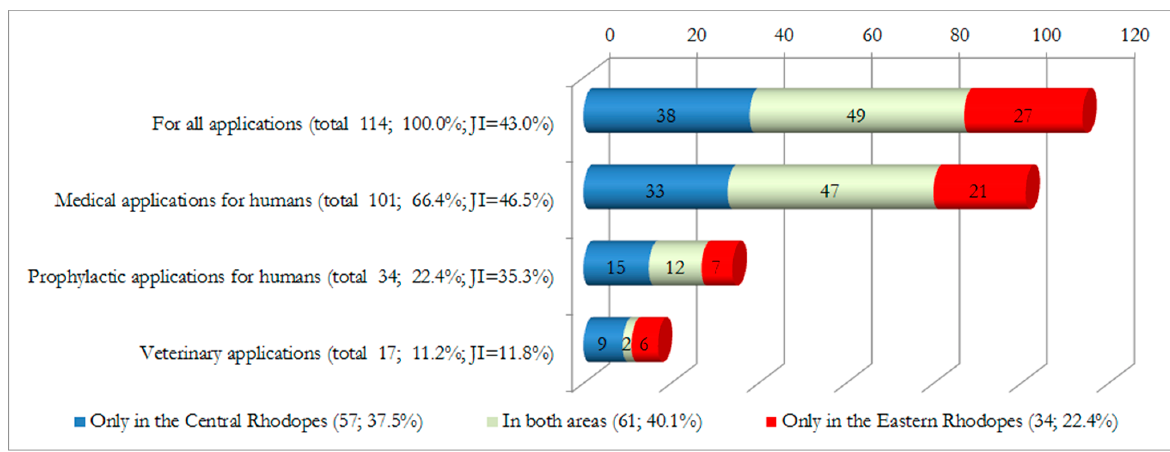
Figure 4. Total number of identi fi ed plant species by application and region.